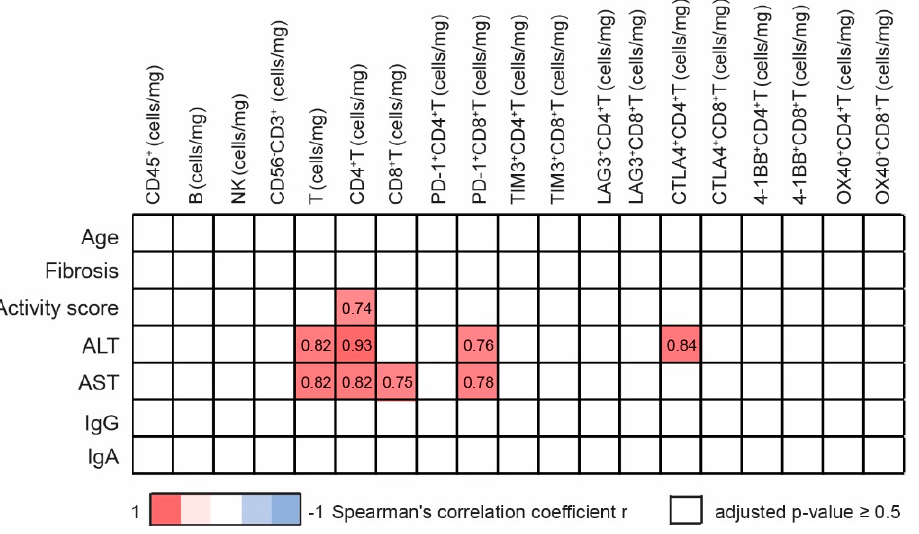
Figure 3. Correlation of patient characteristics and intrahepatic lymphocyte characteristics in un- treated AIH group. Only significant correlations (Bonferroni-corrected p value < 0.5) are reported, numbers correspond to Spearman correlation coefficient r, positive correlation (red), negative cor- relation (blue), n = 11.